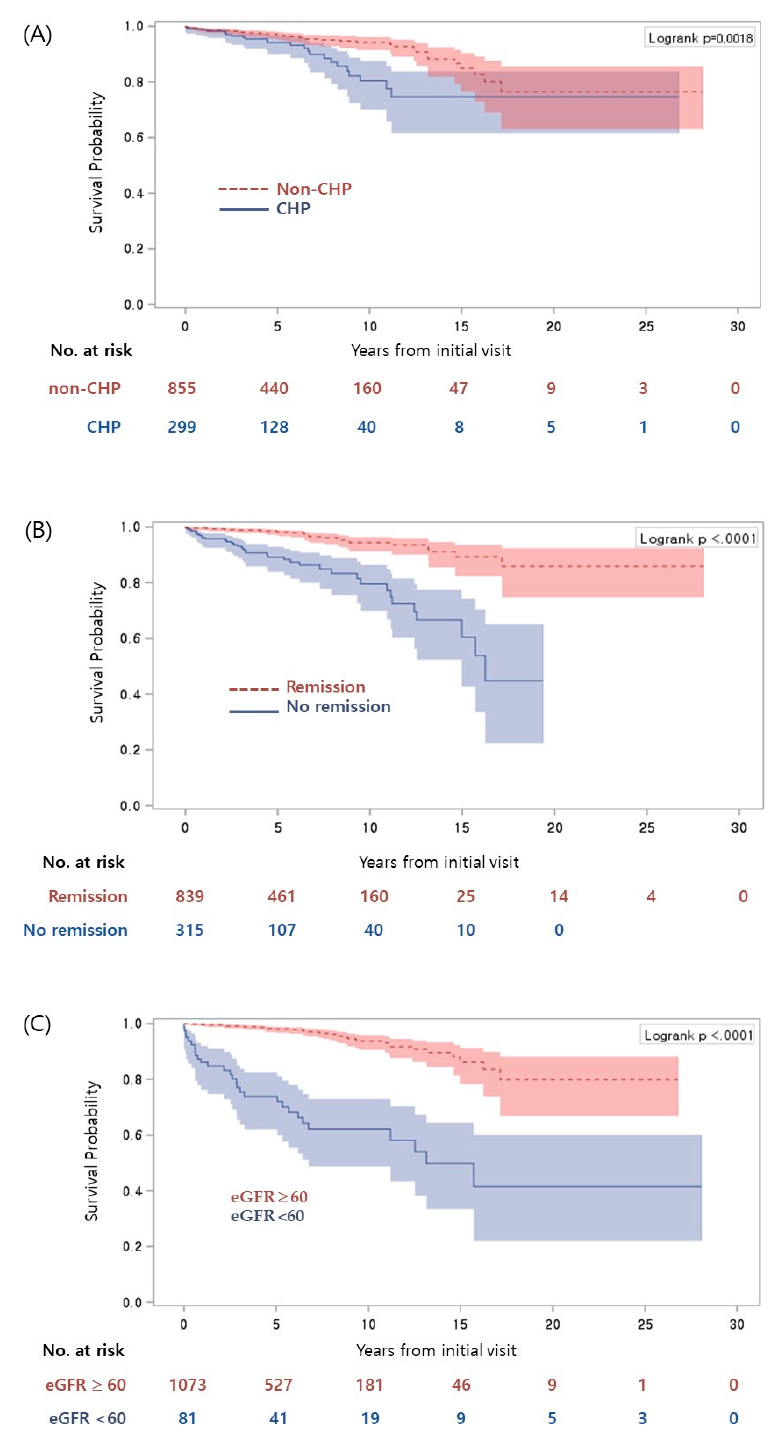
Figure 3. CKD–free survival rates with respect to three significant associated/independent factors. ( A ) Combined hematuria and proteinuria at presentation (CHP), ( B ) remission of proteinuria during the disease course, ( C ) estimated glomerular filtration rate <60 mL/min/1.73 m 2 at renal biopsy. eGFR: estimated glomerular filtration rate, mL/min/1.73 m 2 .